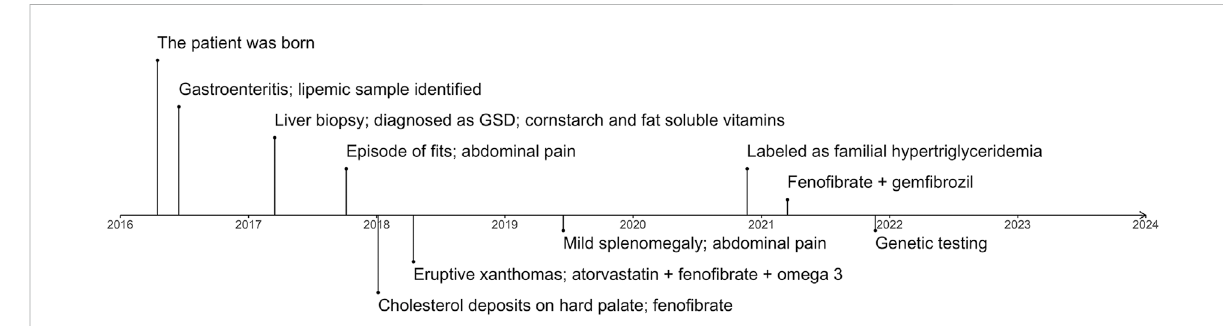
FIGURE 1 The timeline represents important complications and milestones in diagnosing and managing the patient. GSD, glycogen storage